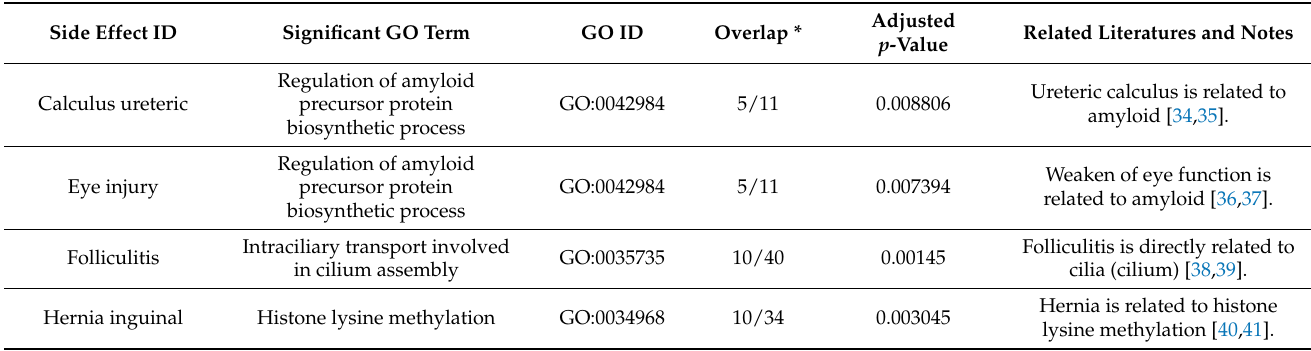
Table 6. Significant term for each 24 side effects, determined by unified